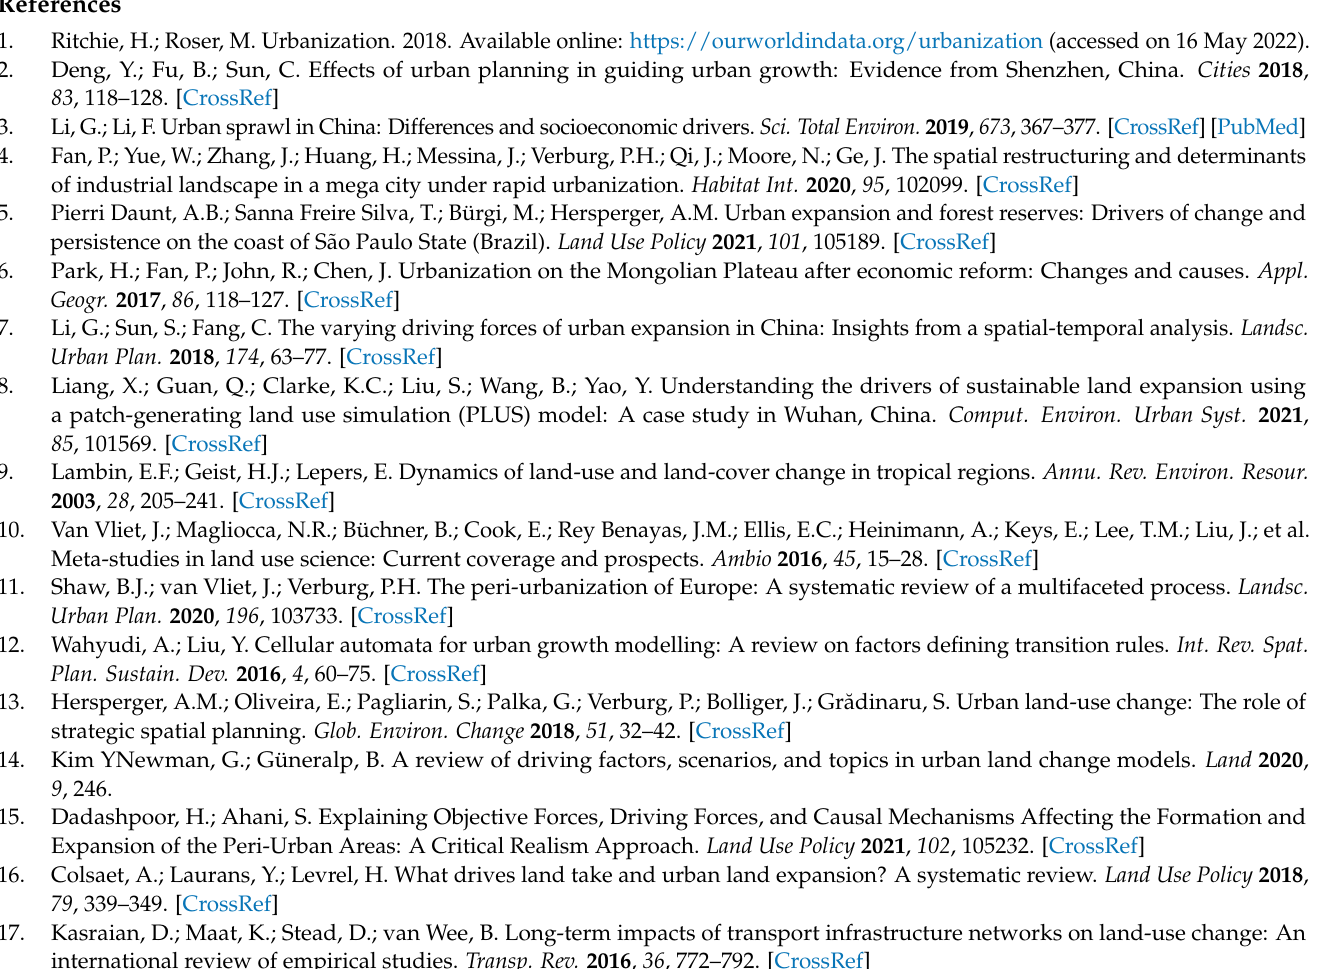
Figure A3. Burst detection of the research theme “GIS”, for which the burst state extended from 2005 to 2013.